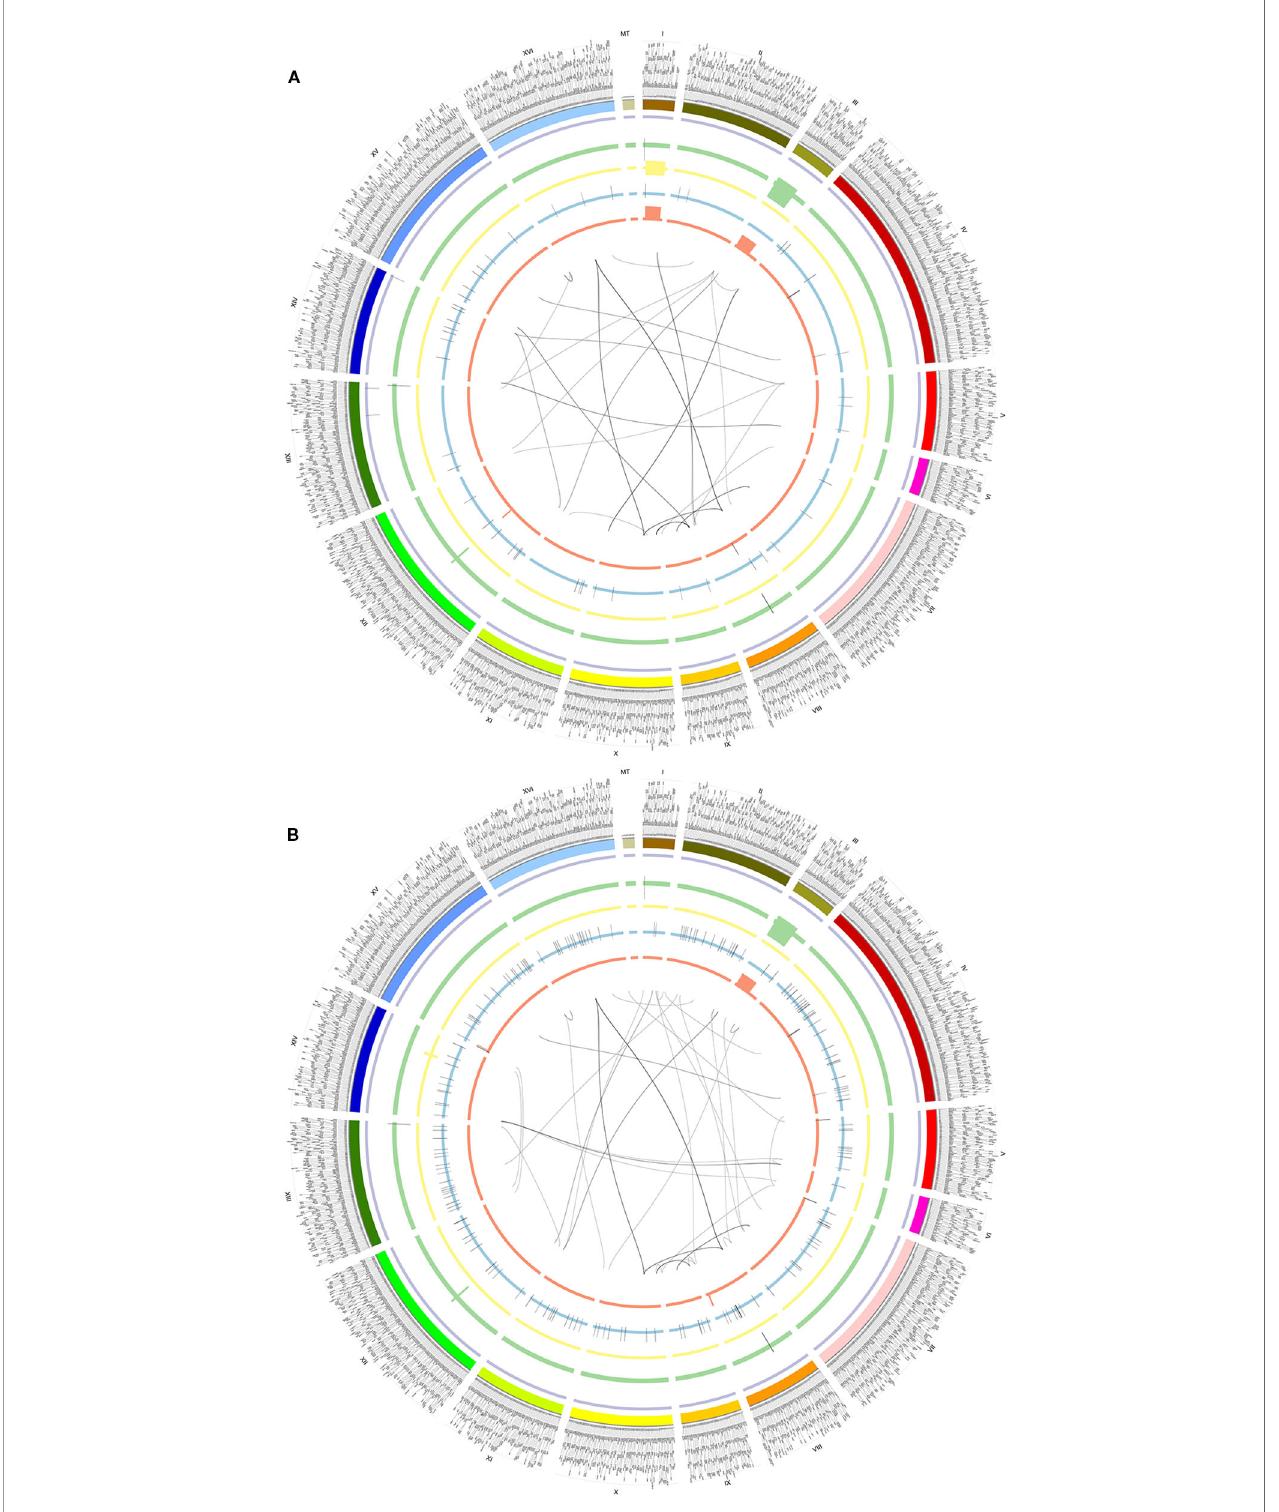
FIGURE 3 | Circos of SVs detected by NGMLR and Snif fl es in BY4742 (A) and SY14 (B) . From outer to inner, the fi rst ring referred to chromosomes, and 2 – 6 were INVDUPs (purple), DUPs (green), INVs (yellow), INSs (blue), and DELs (orange). The inner lines referred to BNDs. The outer text referred to genes. (A) BY4742. (B)